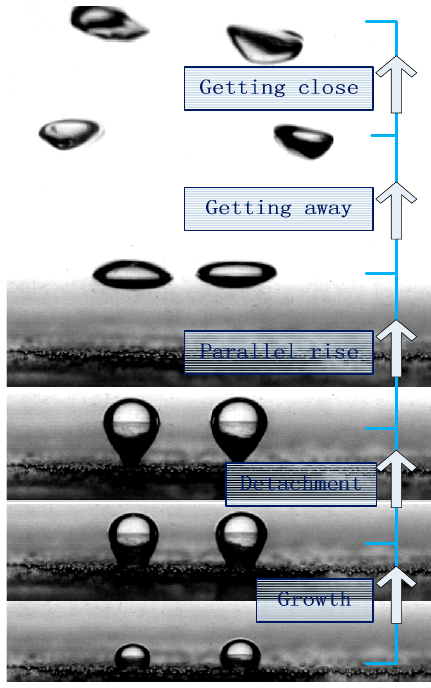
Figure 6. Five stages of two bubbles’ formation and movement.